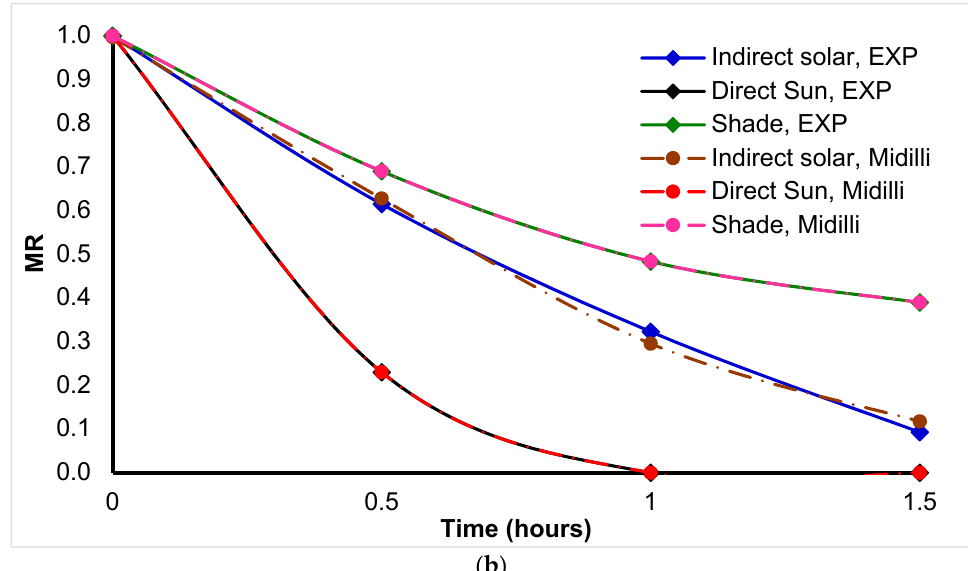
Figure 5. Drying kinetic model resemblance for Mint drying during ( a ) winter and ( b ) summer sea ‐ sons.